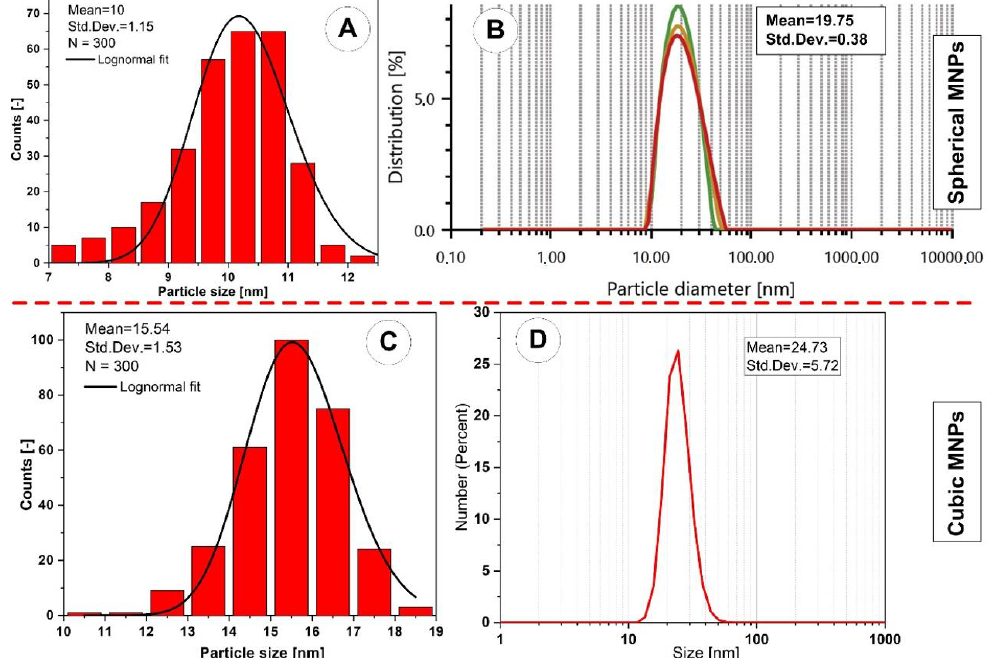
Figure 6. IONPs’ core size distribution by TEM images for spherical ( A ) and ( C ) cubic MNPs. The mean hydrodynamic diameter was measured using the Malvern Instrument Zetasizer Nano series for ( B ) spherical MNPs, and ( D ) cubic MNPs. Figure ( B ) shows three measurements for the same spherical MNPs sample.